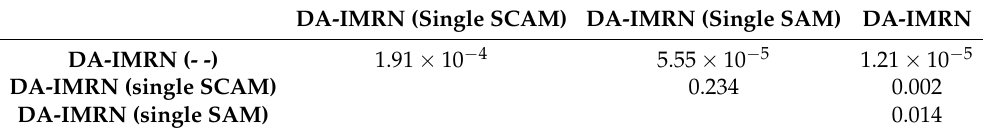
Table 7. Results of two-tailed Wilcoxon’s tests over per-class accuracy for the proposed networks.